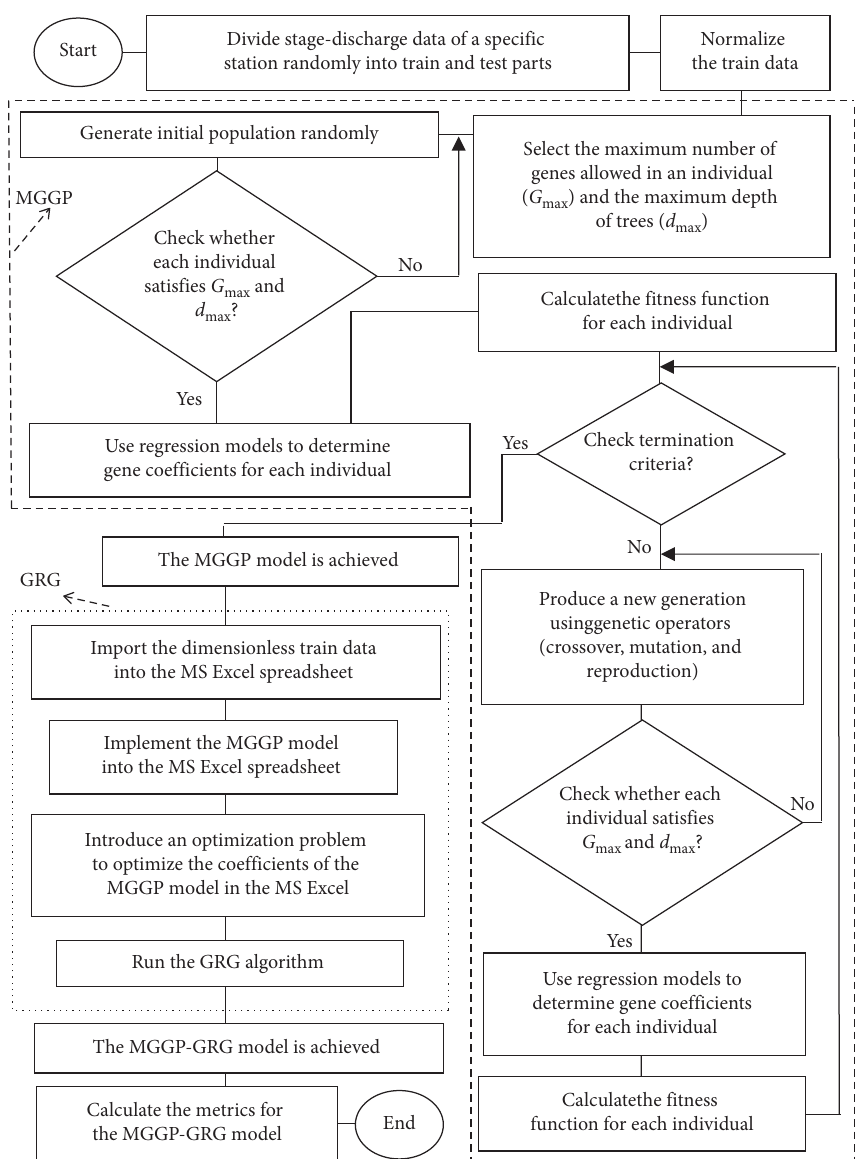
Figure 2: Flowchart of the hybrid MGGP-GRG model for developing rating Table 3: Coefficients of equation (1) calibrated by the conventional method, EA, and the MHBMO algorithm. Method